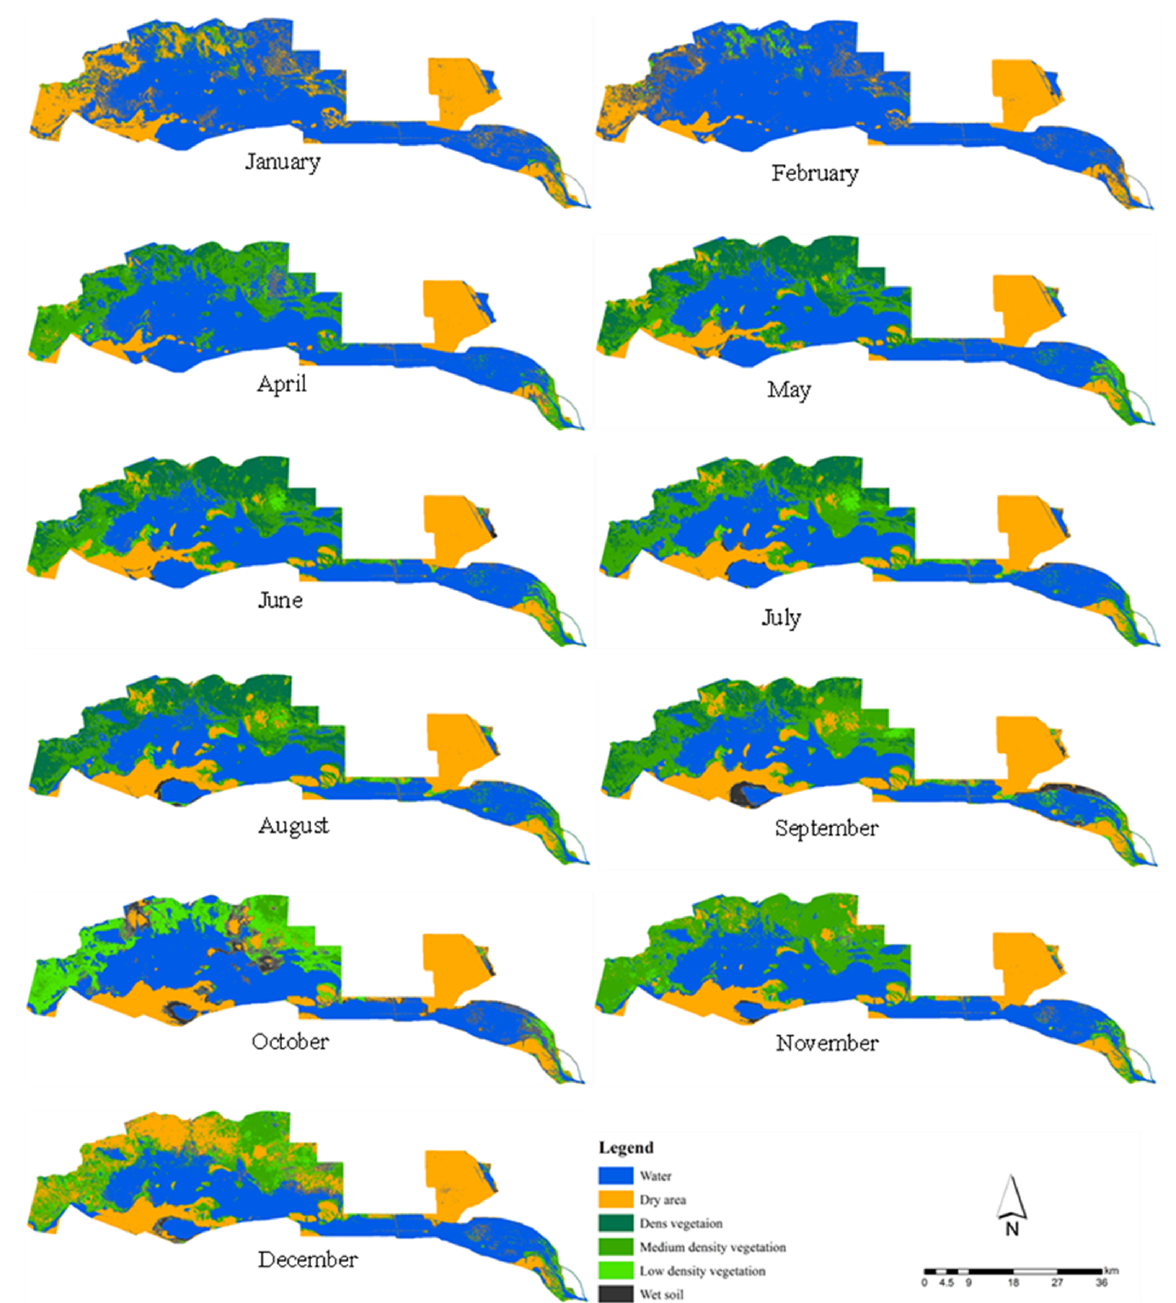
Figure 6. The extent of the marshland before the drains